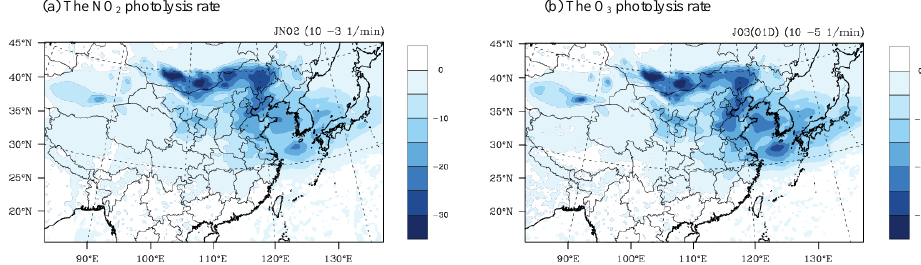
Fig. 11. The average differences of the photolysis rates simulated by DUST_REVISED and DUST_OFF, April 28 to May 6.